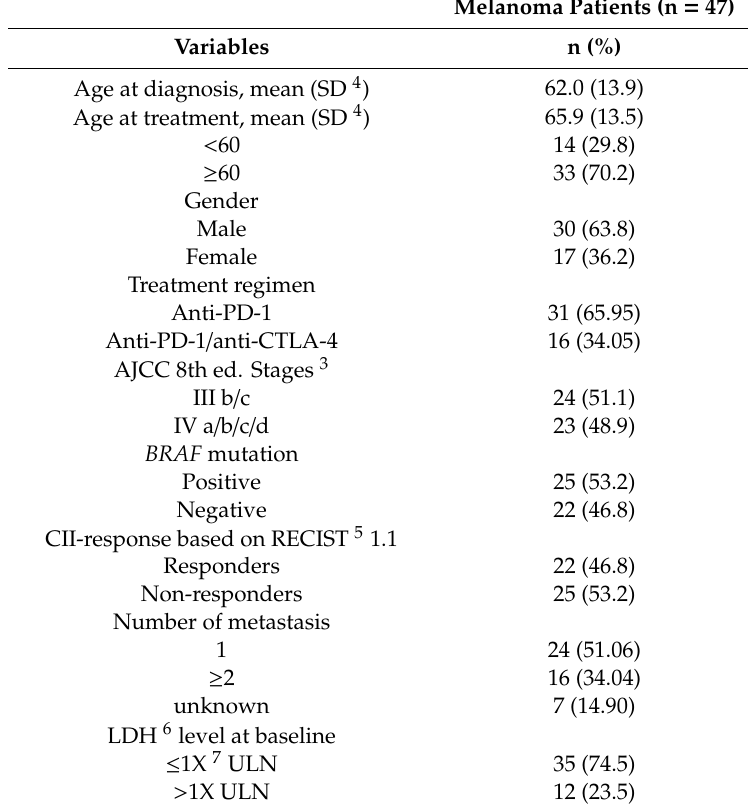
Table 1. Clinical pathological information for metastatic melanoma patients receiving CII 1 analyzed for cfmiRs 2 in plasma